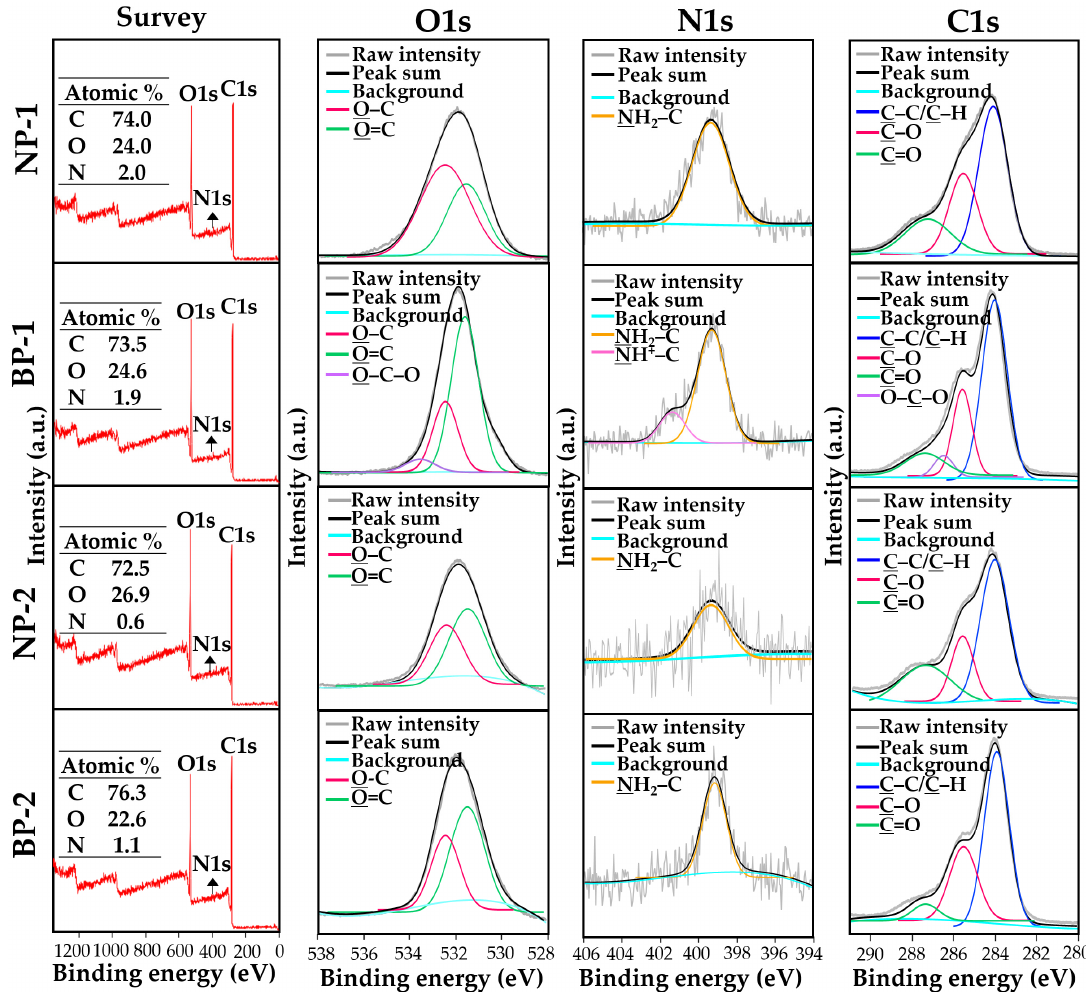
Figure 3. X-ray photoelectron spectroscopy (XPS) survey and high-resolution spectra (O1s, N1s, and C1s) of TD-NPs (NP-1 and NP-2) or conventional BPs (BP-1 and BP-2). Abbreviations: TD-NP, top-down-approach-produced nanoparticle; BP, bulk-sized particle; NP, nanoparticle.